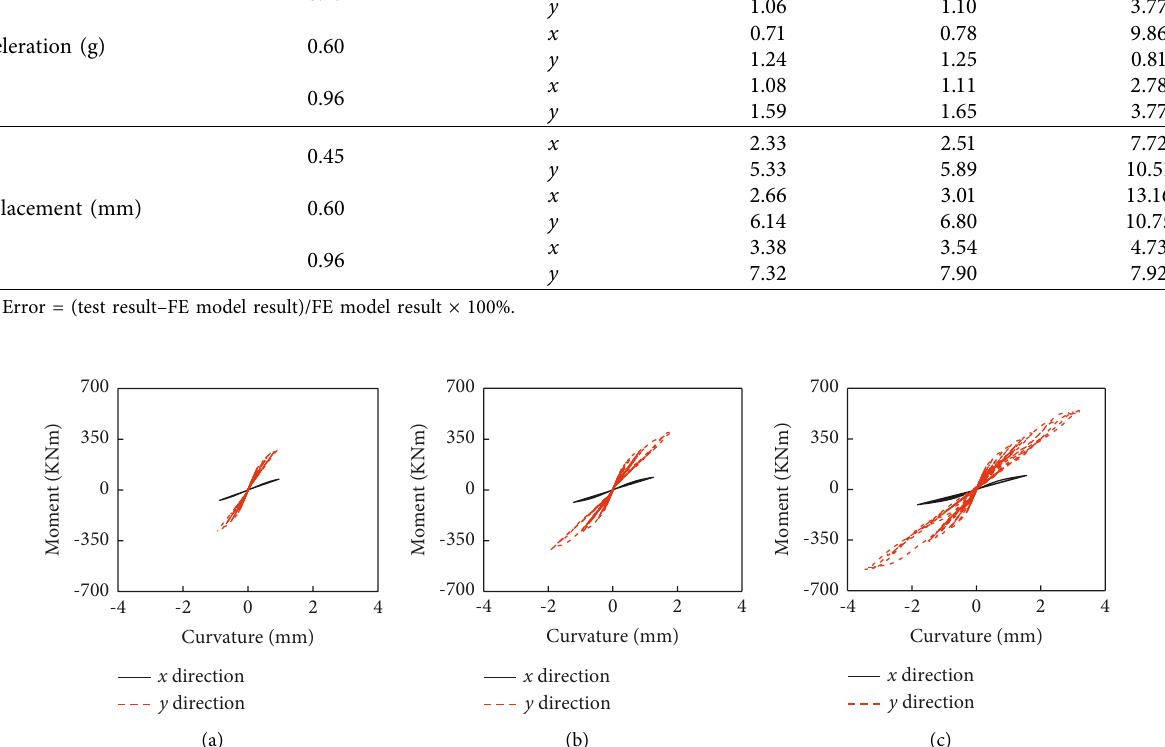
1/2, β 1/4) method (cid:31) (cid:31)